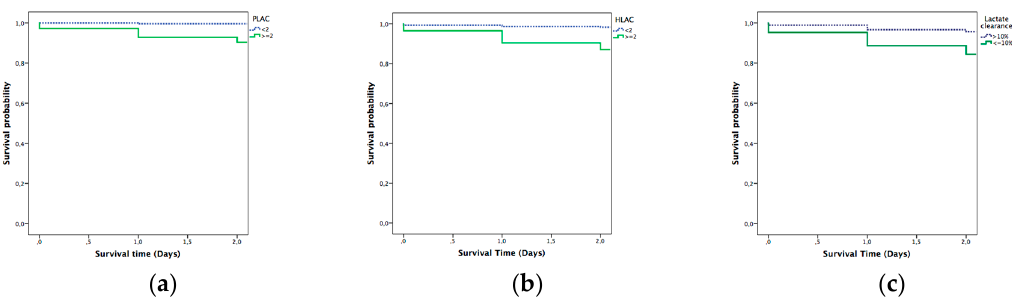
Figure 3. Kaplan–Meier analysis for 2 day mortality: ( a ) prehospital lactate; ( b ) hospital lactate; and ( c ) lactate clearance. PLAC: prehospital lactate; HLAC: hospital lactate.